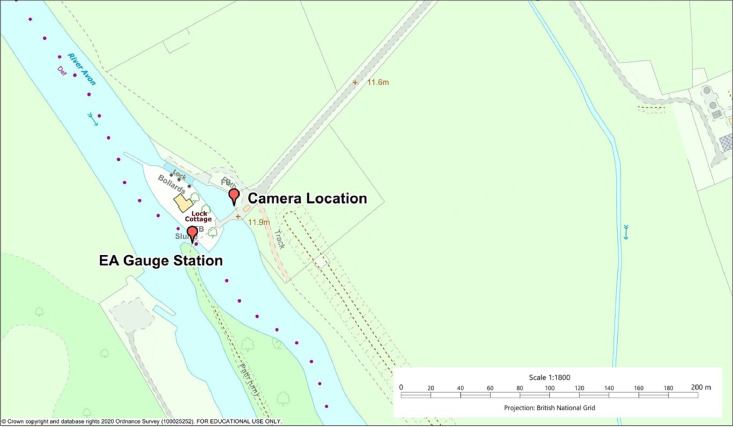
Map illustrating Strensham Lock camera on river Avon and nearest EA river gauge 'Eckington Sluice' (labelled red teardrop shape markers). The map projection is British National Grid and the map scale is given in the bottom right. The vertical is aligned with true North. Produced using EDINA Digimap Ordnance Survey Service, Date created: 09/03/2020. (For interpretation of the references to colour in this figure legend, the reader is referred to the web version of this article.)